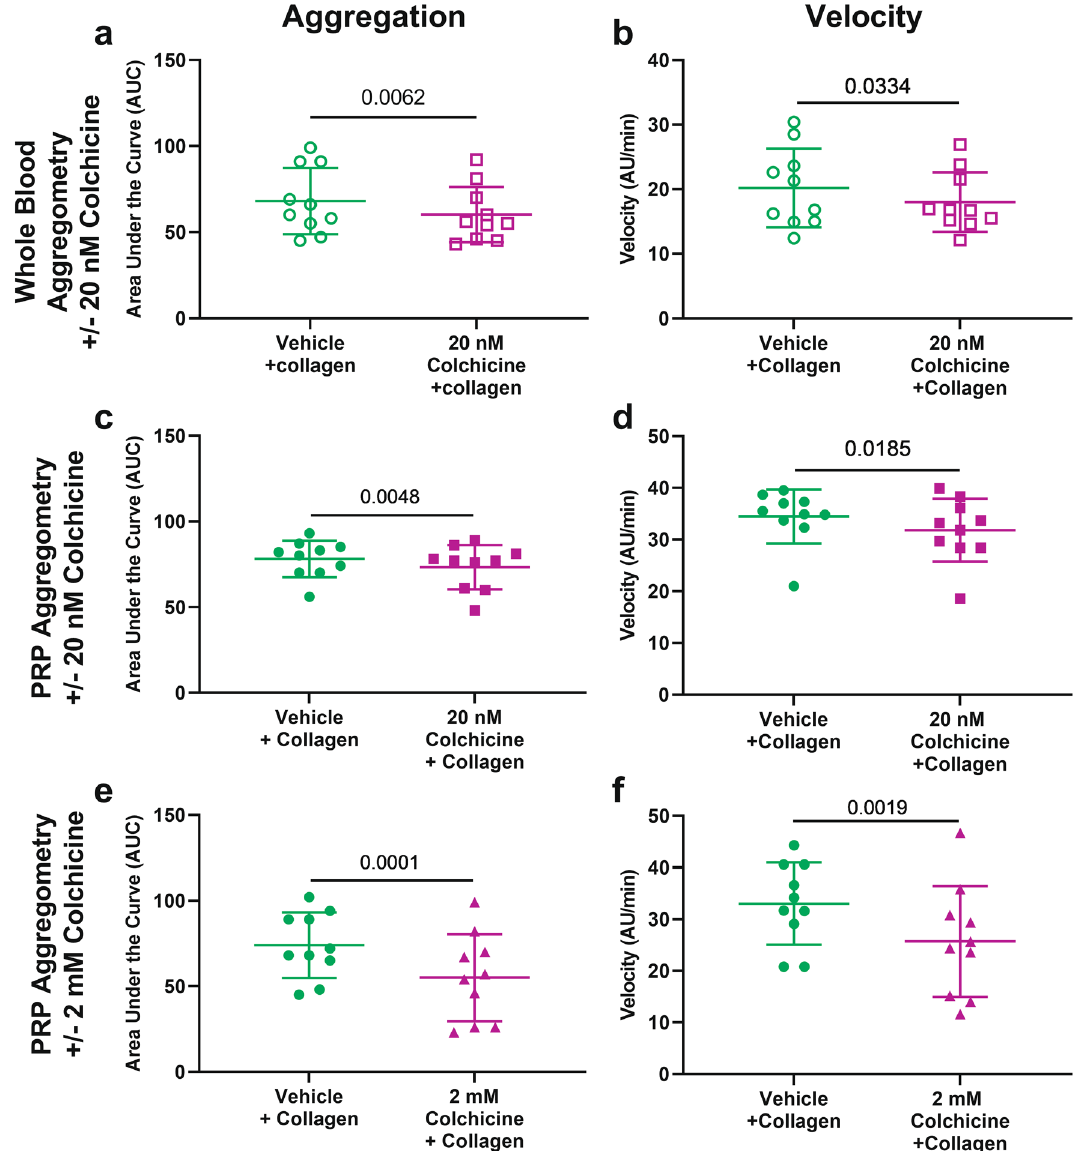
Figure 1. Colchicine decreases platelet aggregation response to collagen in whole blood and platelet rich plasma (PRP). Hirudinised whole blood and PRP from healthy controls (n = 10) was assessed for platelet aggregation and the rate of aggregation (velocity) after incubation with collagen (3 µg/mL) in the presence or absence of 20 nM colchicine and 2 mM colchicine (PRP only). Significant decrease in aggregation and velocity was observed in whole blood (p = 0.006 and p = 0.03; a and b ) and in PRP after incubation with 20 nM colchicine (p = 0.005 and p = 0.019; c and d ) and 2 mM colchicine (p = 0.0001 and 0.0019; e and f ). Statistical significance was determined by paired t test to vehicle control. Data presented as mean ±